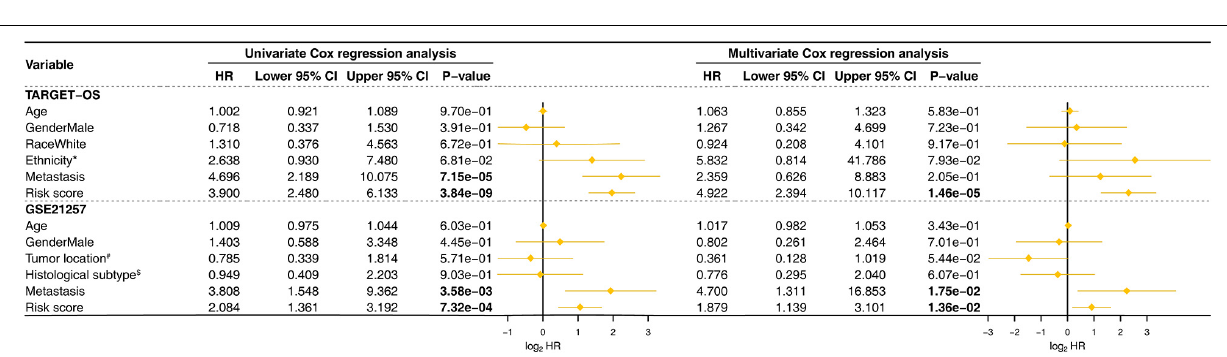
FIGURE 6 | Univariate and multivariate Cox proportional hazards models were built to test the predictive ability of the nine-gene signature in the training and validation cohorts. HR, hazard ratio; CI, confidence interval; The bold p-value indicates that < 0.05, which considers significant. *Hispanic or Latino vs. Non-Hispanic or Latino; # Femur vs. Non-Femur; $ Osteoblastic vs.